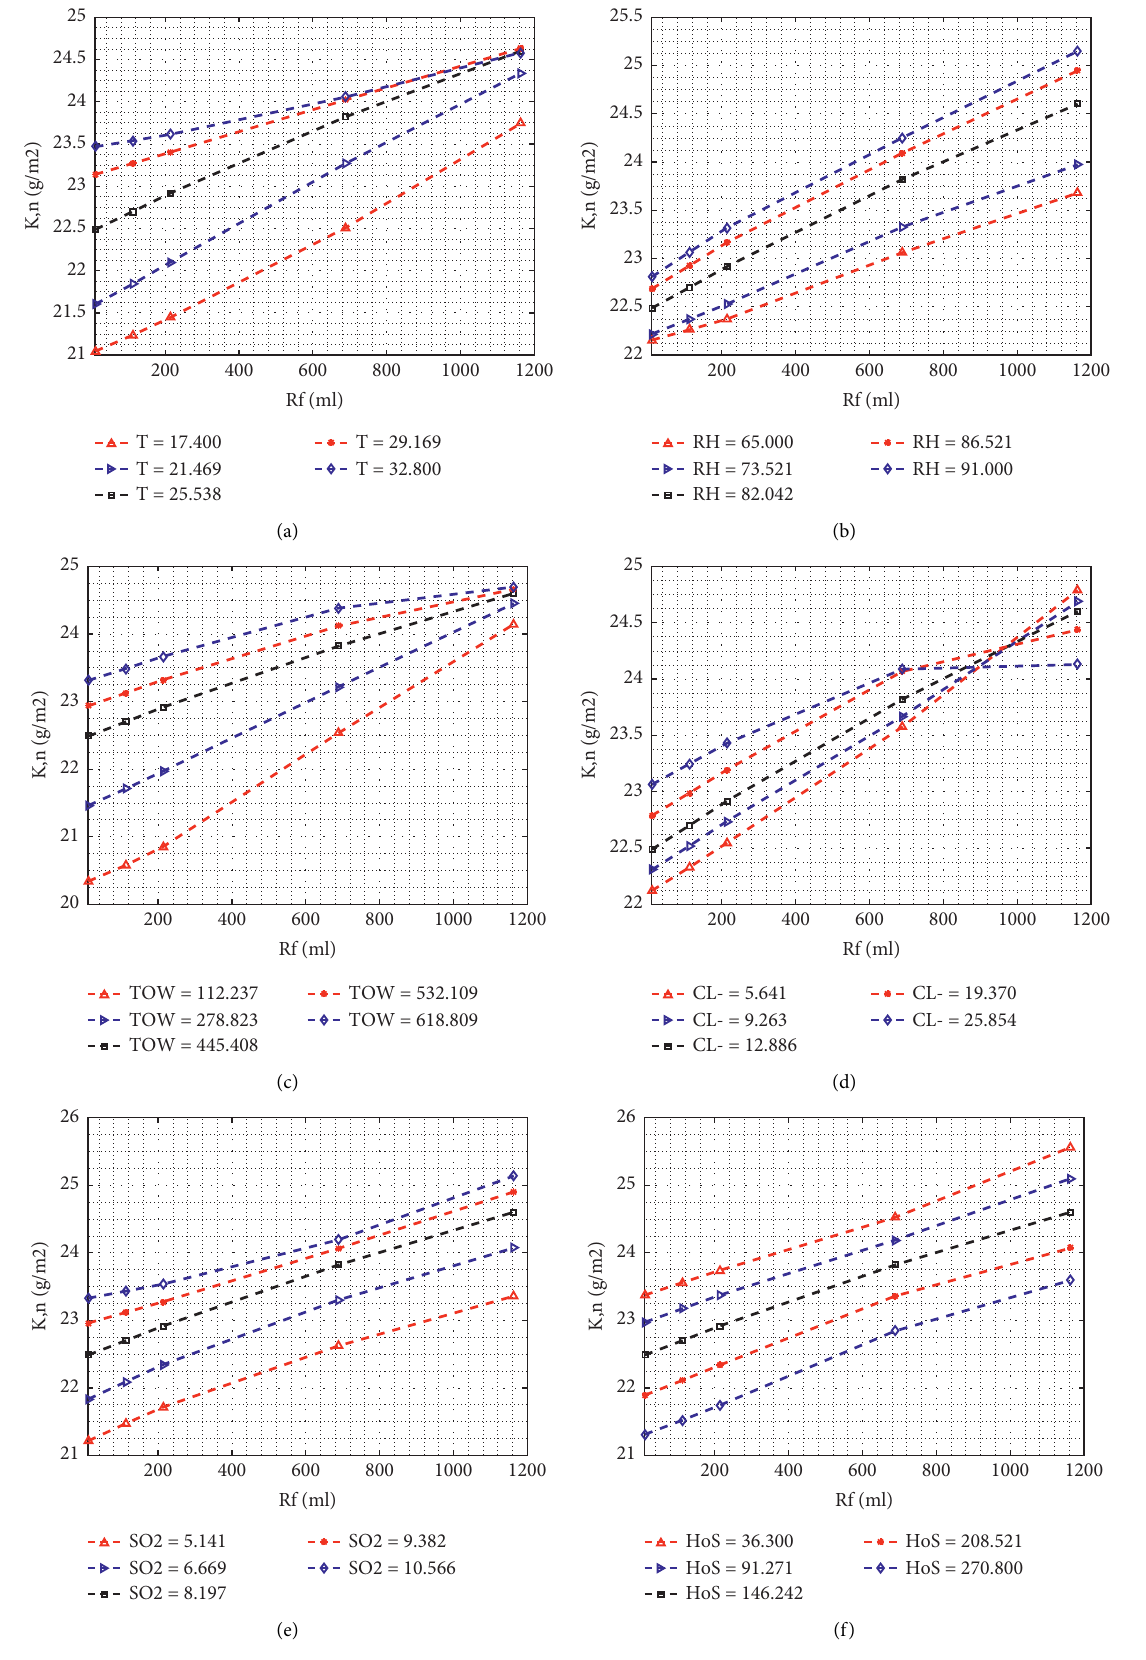
Figure 18: Effects of the